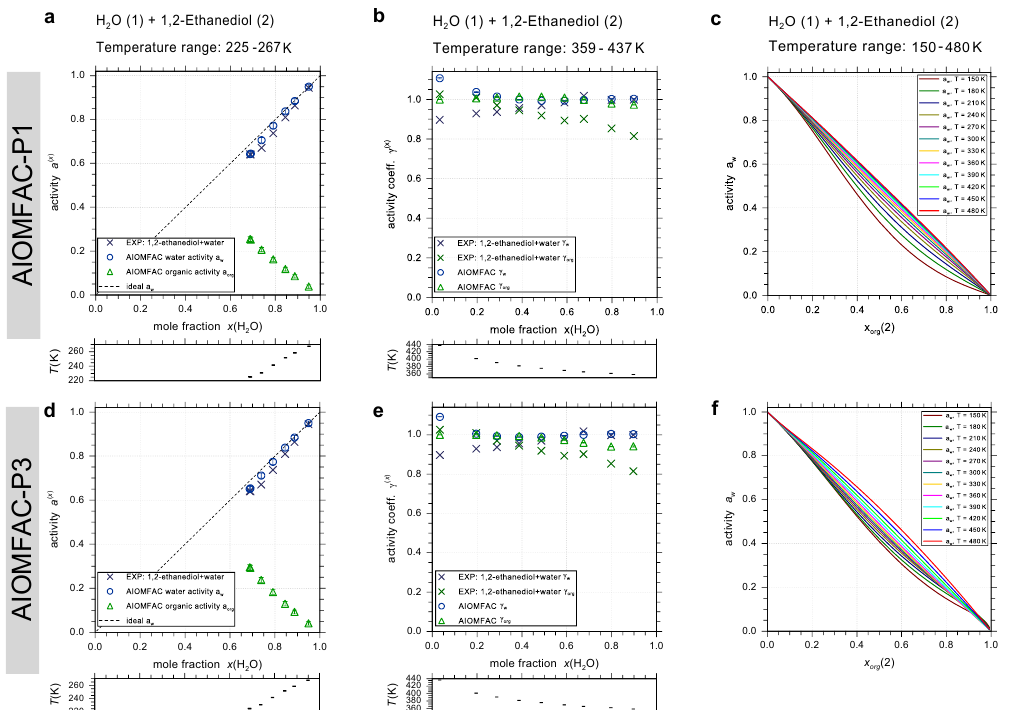
Figure 2. SLE and VLE measurements for water (1) + 1,2-ethanediol (2) solutions and corresponding calculations of AIOMFAC-P1 (a–c) or AIOMFAC-P3 (d–f) . The coloured curves in (c, f) represent the temperature dependence of water activities predicted for the range 150–480K. (a, d) Low temperature experimental SLE data (crosses) are compared with the predictions for water activity at the same compositions and temperatures (blue circles). Predictions of the corresponding organic activities are shown as well (green triangles). The dashed line represents the hypothetical water activity of an ideal mixture. The error bars represent the model sensitivity to a composition variation by x tol = 0 . 01. Panels (b, e) show the model predictions of the activity coefficients compared to VLE data covering temperatures significantly higher than room temperature. The temperatures of the individual data points are given in the boxes below the main panels. Experimental data: Ott et al. (1972) and Gmehling and Onken